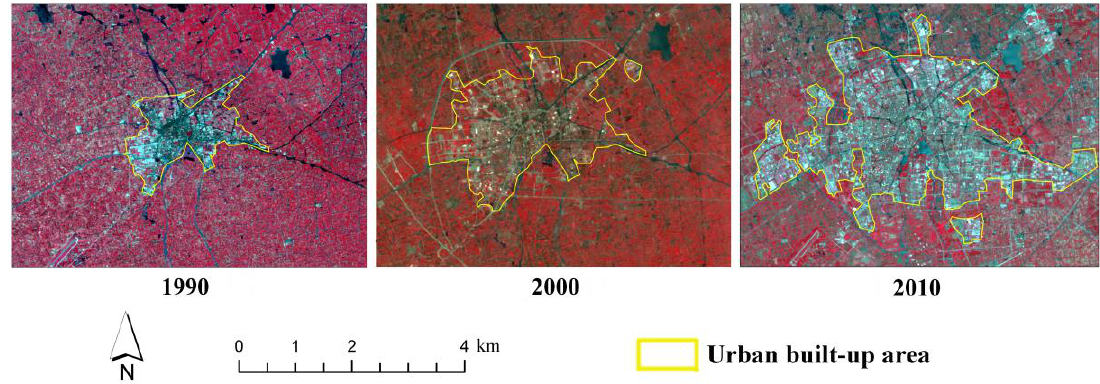
Figure 2. An example of the depicted urban built-up area of 1990, 2000 and 2010.